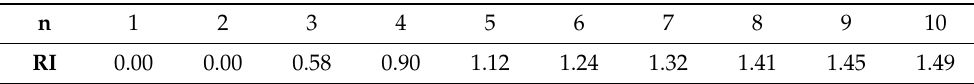
Table 1. Random consistency index values for n